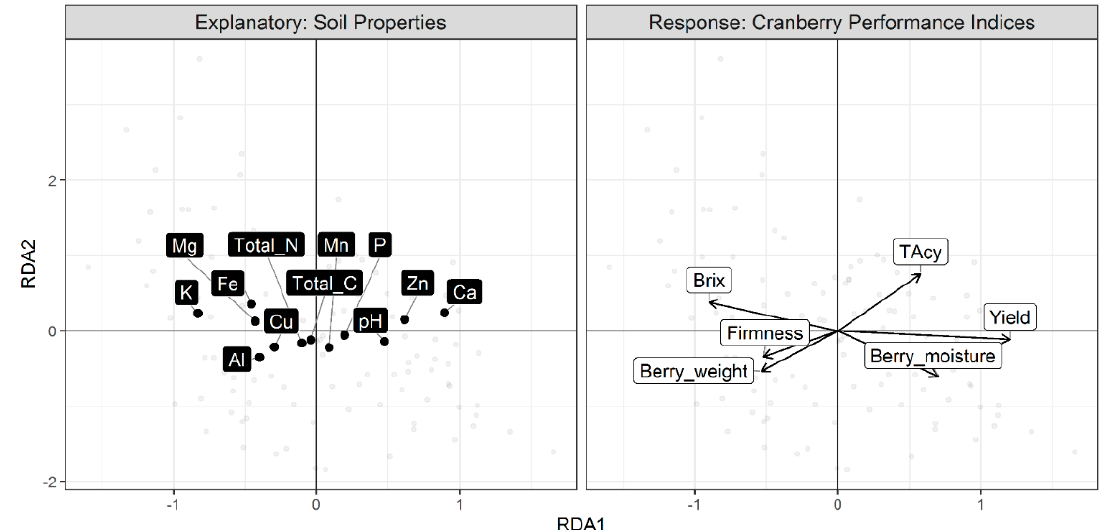
Figure 6. Redundancy analysis relating soil properties on the left to cranberry performance indices on the right. Distances were computed using the Euclidean distance.